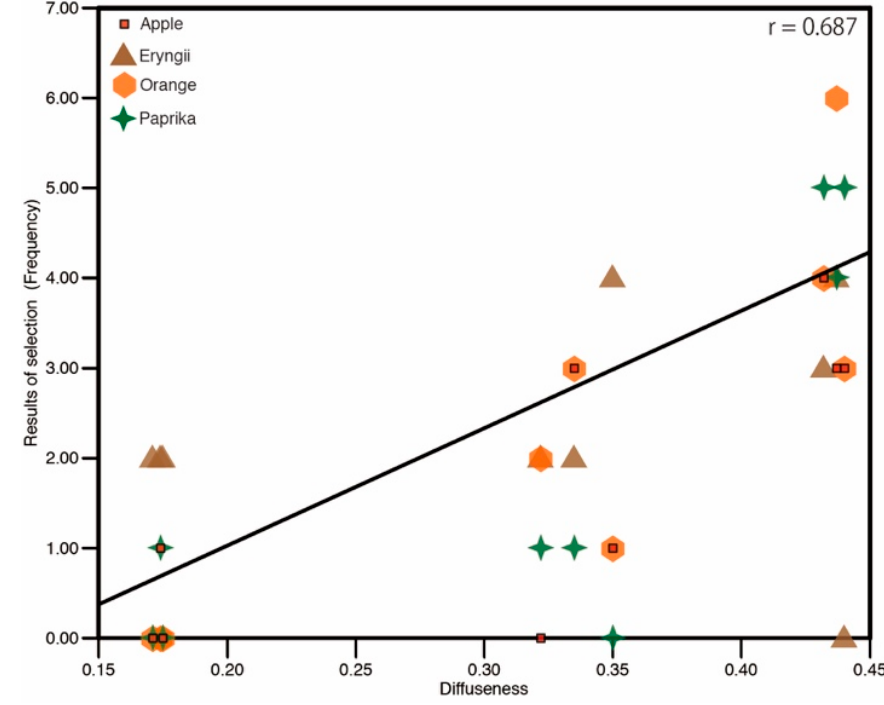
Figure 20. Correlation between diffuseness and fidelity selection.